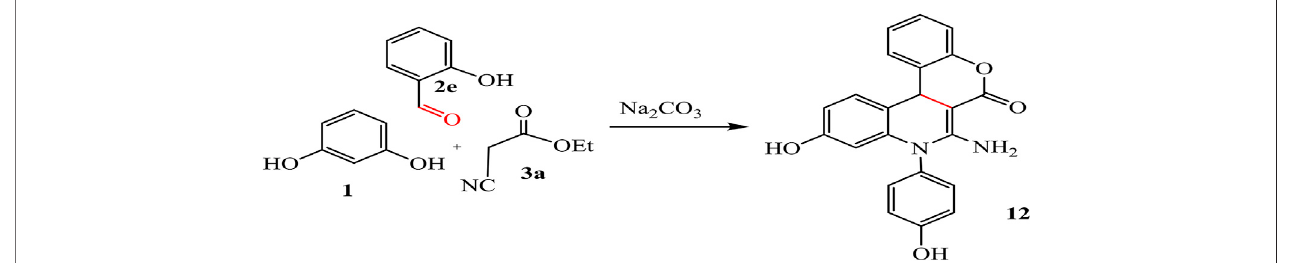
SCHEME 7 | Synthesis of compound 12.